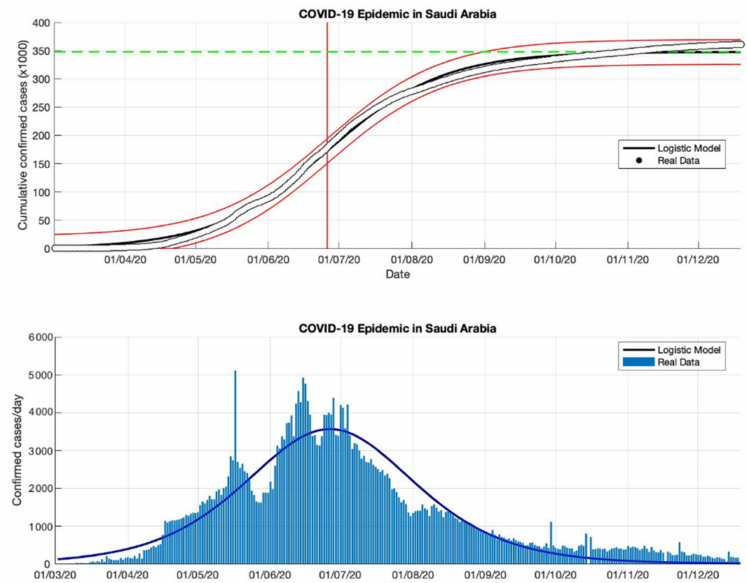
Figure 11. In the above figure, the prediction results of the logistic growth model for cumulative infected cases are compared with the actual data, while the two red lines between the black lines represent a prediction error limit of about 5%. The dashed green line predicts the total size of infected cases in the final phase of the epidemic. The red line intersects the cumulative case curve to predict the turning point or peak point of the epidemic (this line is parallel to the top of the curve from the below figure). In the below figure, the prediction results of this model for daily infected cases